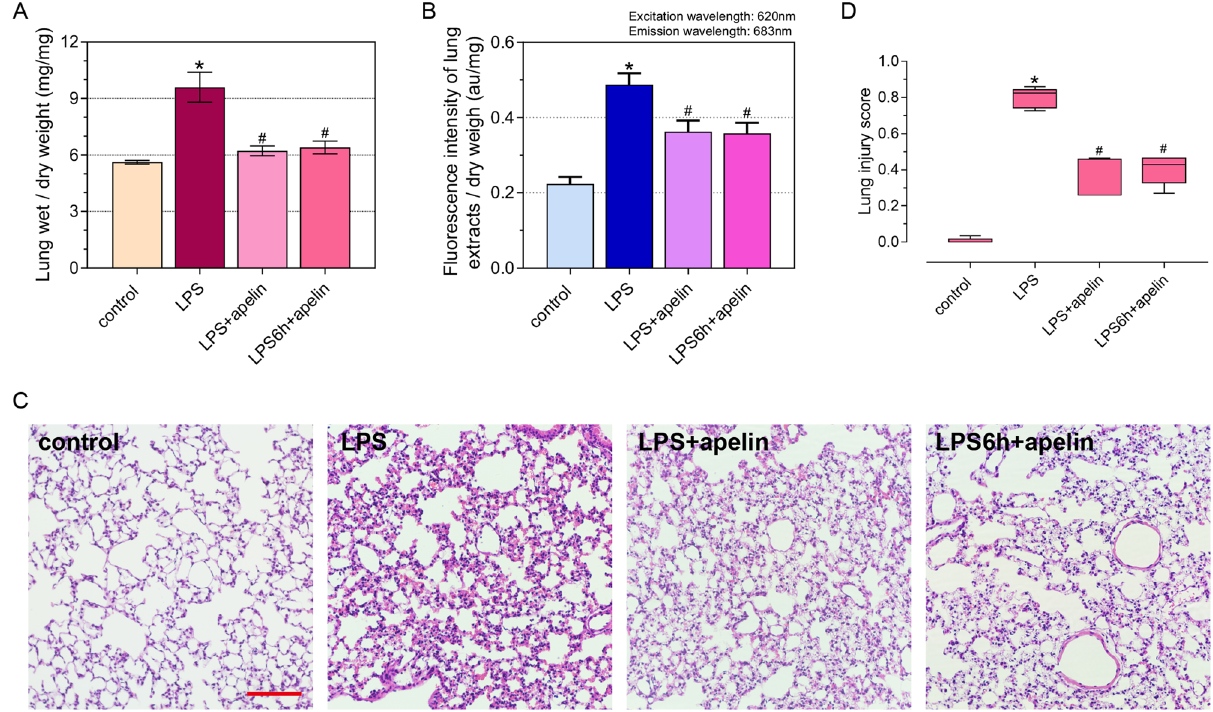
Figure 3. Protective effect of apelin against ALI. ( A ) Lung wet/dry weight ratio to detect changes in whole lung permeability after apelin control effect. ( B ) Evans blue assay to detect changes in pulmonary vascular endothelial permeability after apelin prevention and treatment. ( C ) HE staining demonstrating the inflammatory response of lung tissue after apelin control (×200 magnification, scale bar: 100 μm for all images). ( D ) Lung injury score on HE staining (n = 5). Data are presented as the mean ± SEM. *P < 0.05 vs. the control group, and # P < 0.05 vs. the LPS